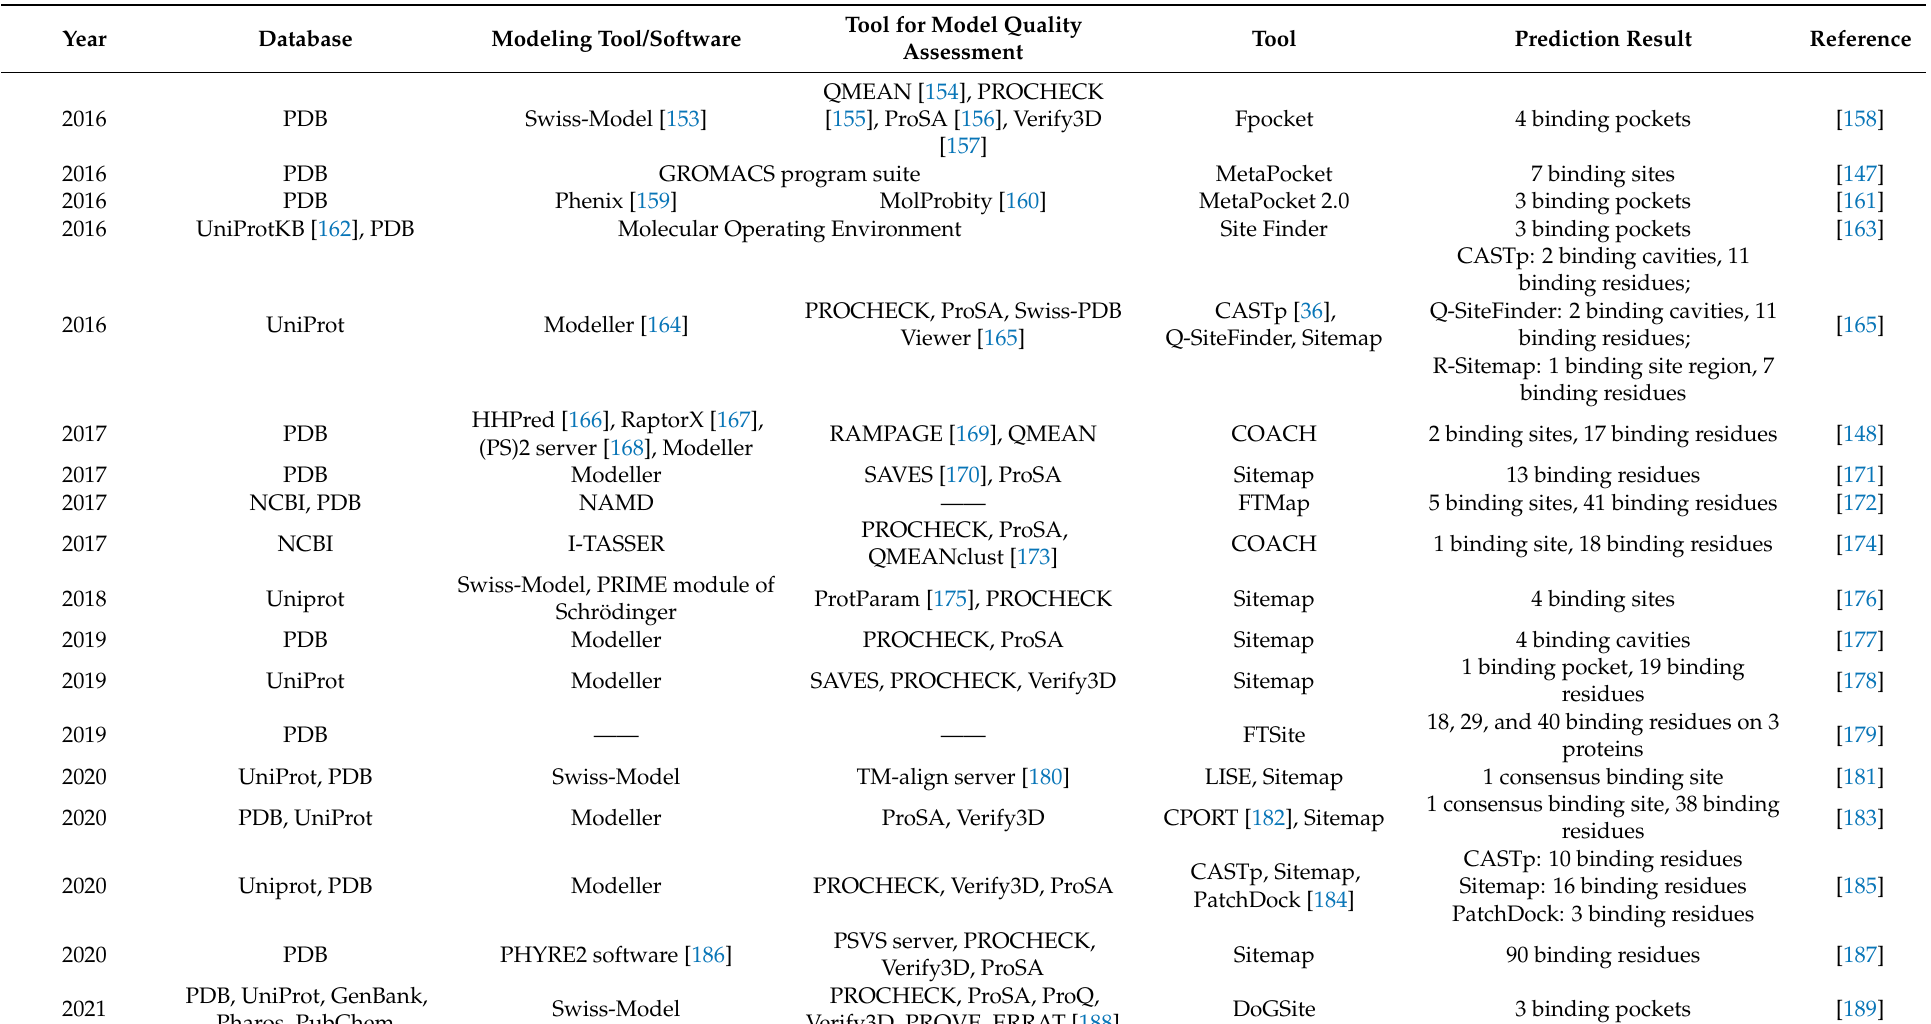
Table 7. Applications of databases/tools in binding site identification from 2016 to